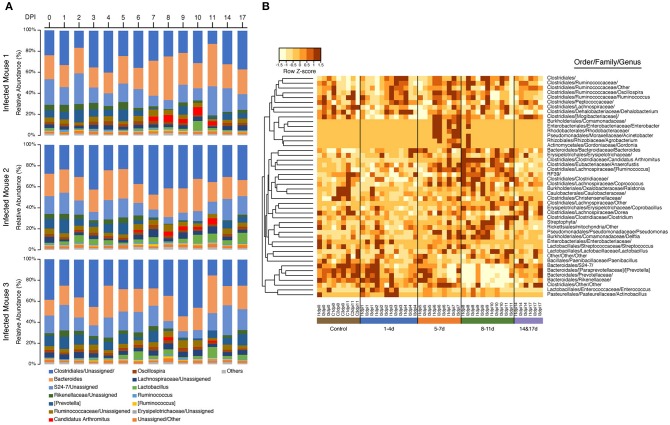
Impact of Strongyloides venezuelensis infection on the gut bacterial community composition. (A) Relative abundance of the fecal microbiota at the genus level in infected mice. The taxonomic composition and relative abundance of bacterial genera in the fecal samples with the progression of S. venezuelensis infection are shown. Taxa with relative abundances of <1% are included in “Others.” (B) Heatmap of the operational taxonomic unit (OTU) abundance in individual mice demonstrating large-scale community shifts at 5–7 and 8–11 days post-infection (DPI). Each column represents an individual sample from the control or infected mice during infection, while each row represents a genus-level OTU Values were normalized by row.